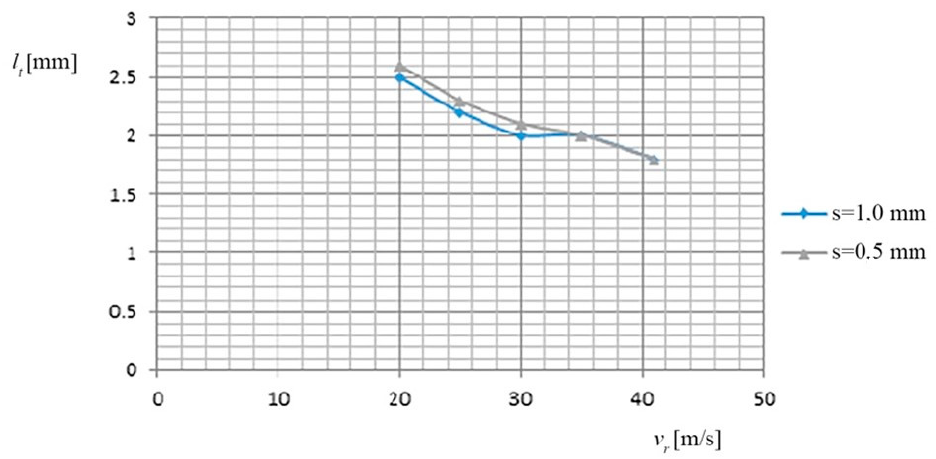
Figure 3. Dependence l t , on the v r of TO and on the thickness ( s ) of the metal band.